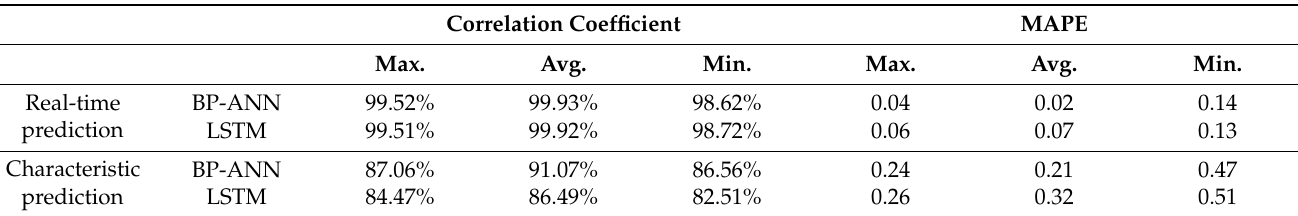
Table 2. The correlation coefficient and MAPE assessment indices for daily temperature prediction results of two models using BP-ANN and LSTM